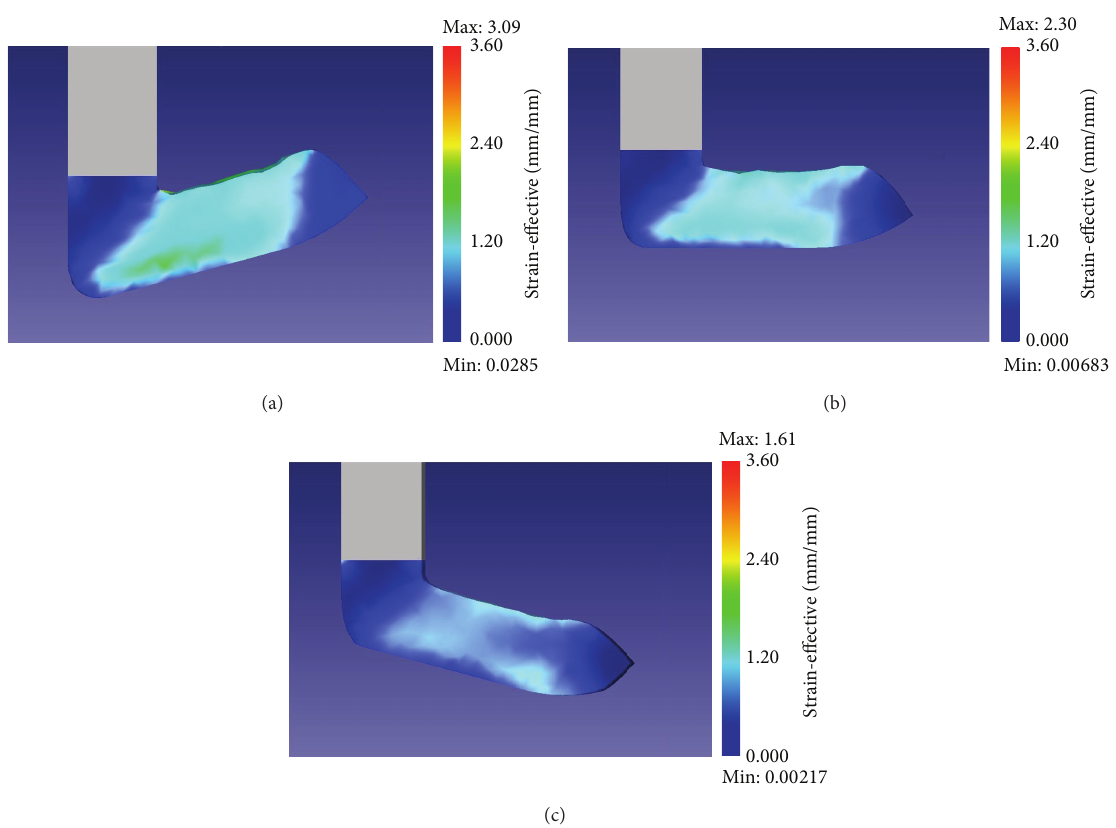
Figure 9: The effective strain distribution of the workpiece after ECAE process with different extrusion velocity: (a) Φ = 75 ∘ , (b) Φ = 90 ∘ , and (c) Φ = 105 ∘